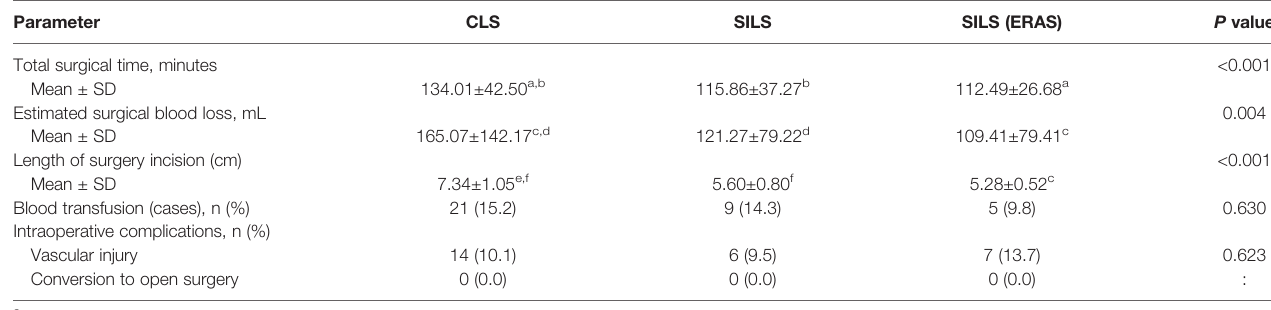
TABLE 3 | Operative data.